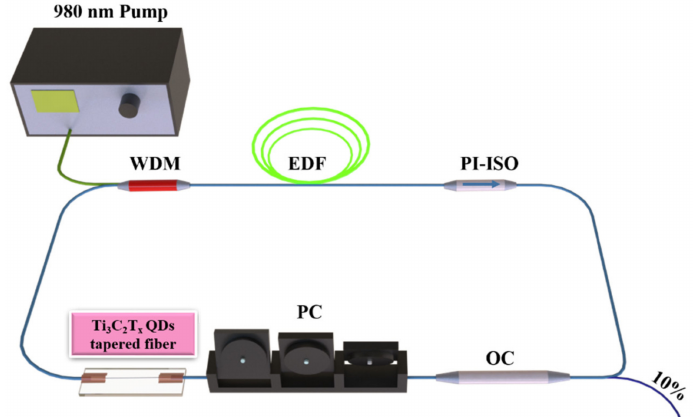
Figure 6. Structure diagram of the Er 3+ -doped fiber laser